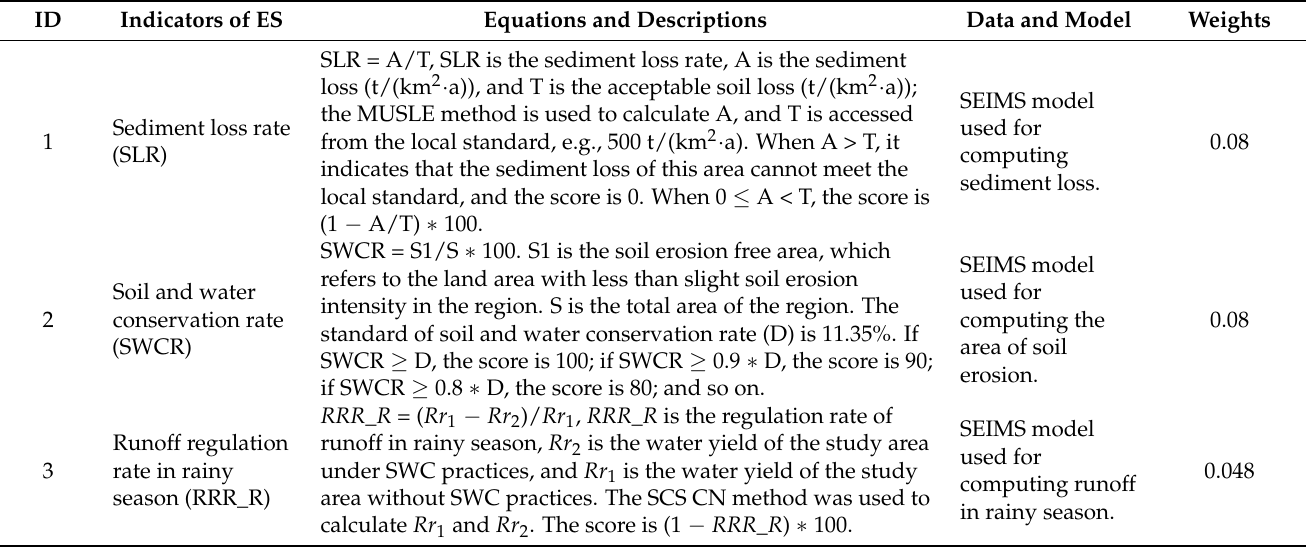
Table 4. The equations for indicators of ES and a comprehensive score of